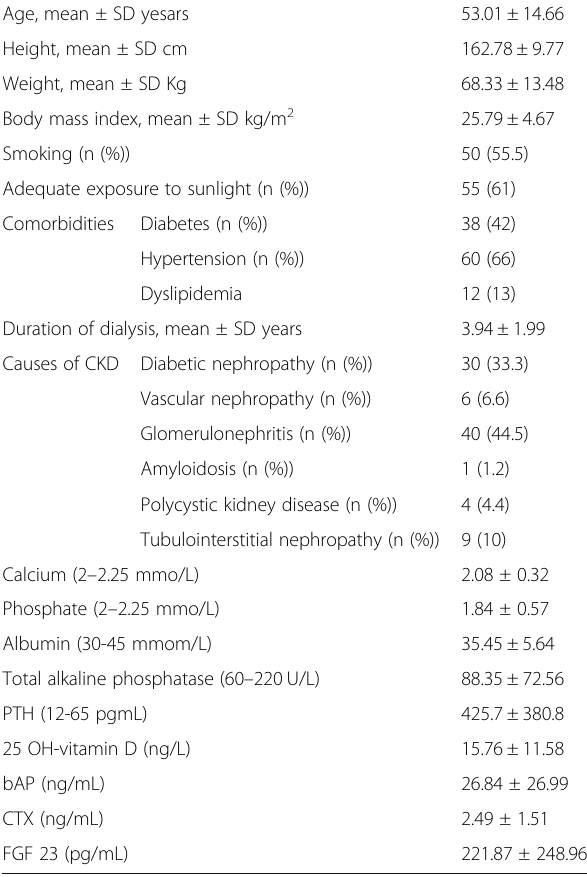
Table 1 Clinical and biological characteristics of patients Age, mean ± SD